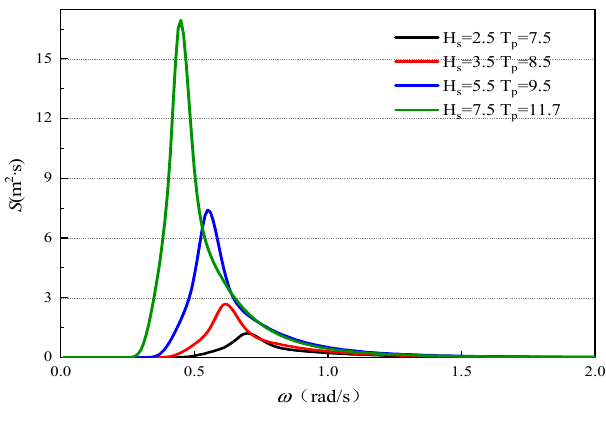
Figure 6. Wave spectrum. Figure 6. Wave Table 4. Wave spectrum parameters for numerical simulation.